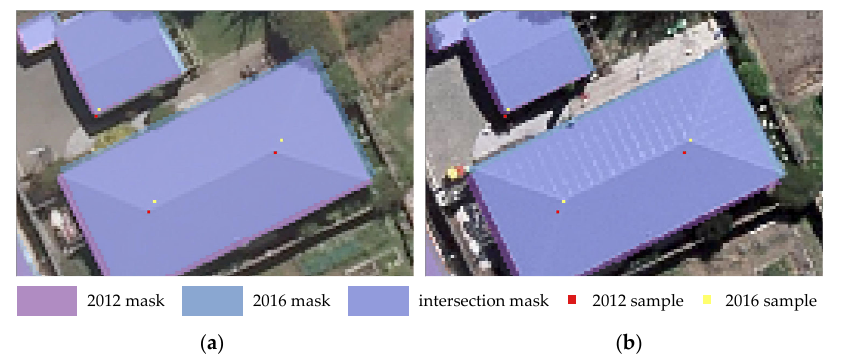
Figure 14. Offset of the Wuhan University building change detection dataset. ( a ) Red sample point and dull purple mask in 2012. ( b ) Yellow sample point and oxide blue mask in 2016. Light blue-purple represents intersection mask.